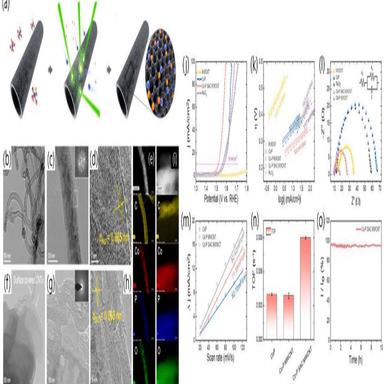
(a) Schematic illustration of the material design concept for Co–P Single-atom catalyst (SAC) on multi-walled carbon nanotubes (MWCNTs). (b, c) Lowresolution TEM image of Co–P SAC MWCNT and the corresponding Fast Fourier transformation (FFT) patterns (inset). (d) High resolution TEM (HR-TEM) image of Co–P SAC MWCNT showing the lattice plane of the carbon nanotube (CNT). (e) Elemental mapping image of C, Co, P, and O in as-prepared Co–P SAC MWCNT. (f, g) Low-resolution TEM image for Co–P MWCNT and the corres